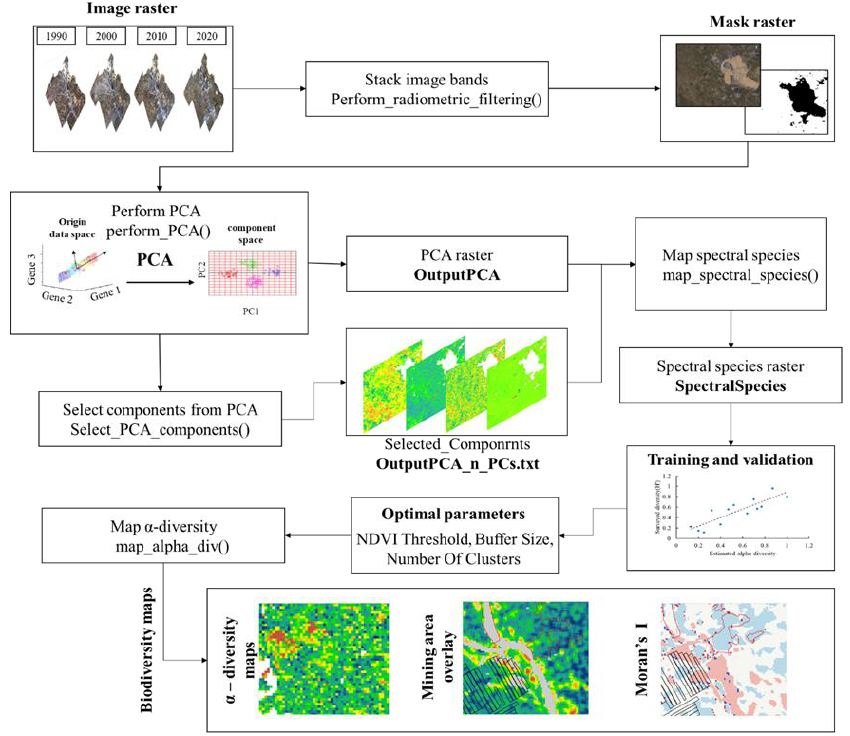
Figure 2. Diagrammatic representation of the steps used to estimate alpha diversity.